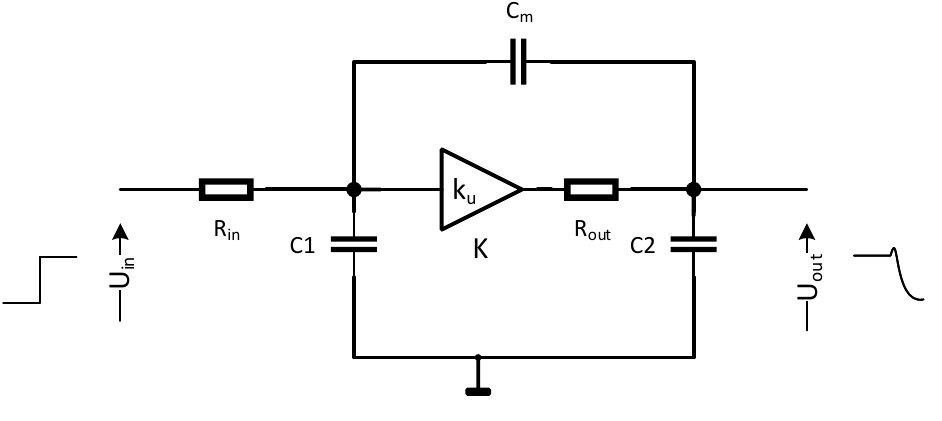
Figure 8. Nonlinear inverter